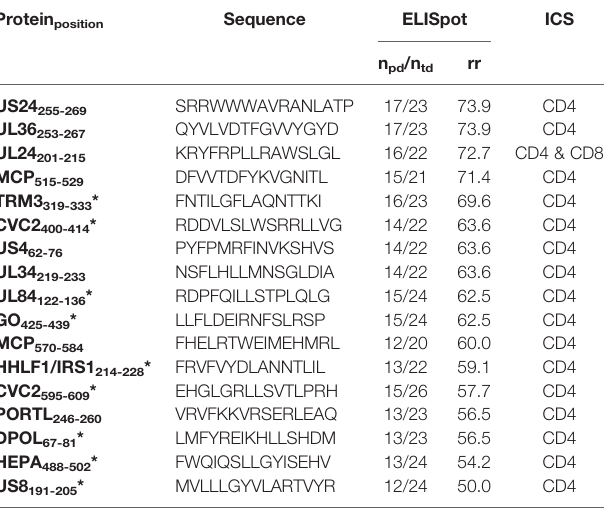
TABLE 2 | ELISpot and ICS results of HCMV epitope